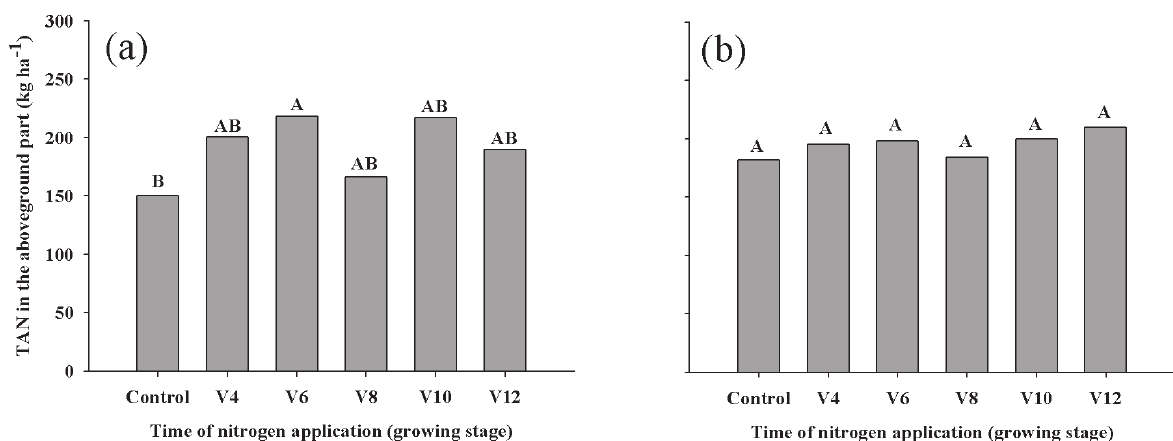
Figure 3 - Total accumulated nitrogen (TAN) in the aboveground part of corn plants as a function of urea sidedress timing during 2011–2012 ( a ) and 2012–2013 ( b ). Control indicates absence of sidedress N application. Columns with different letters differ between each other by Tukey’s test ( p ≤0.05). Coefficients of variation for the 2011–2012 and 2012–2013 growing seasons were 15 and 8%,